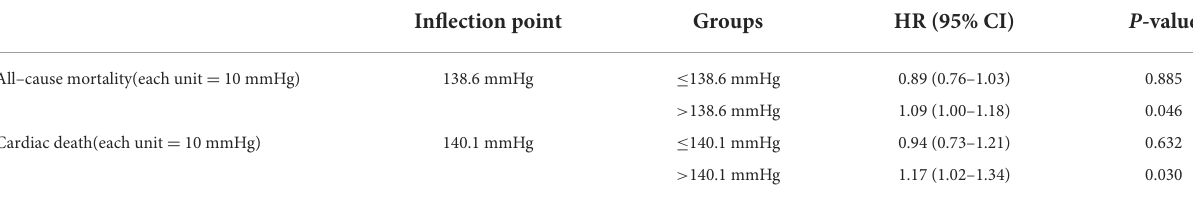
TABLE 3 The threshold effect analysis of SBP on mortality using a piecewise Cox regression model. Inflection point